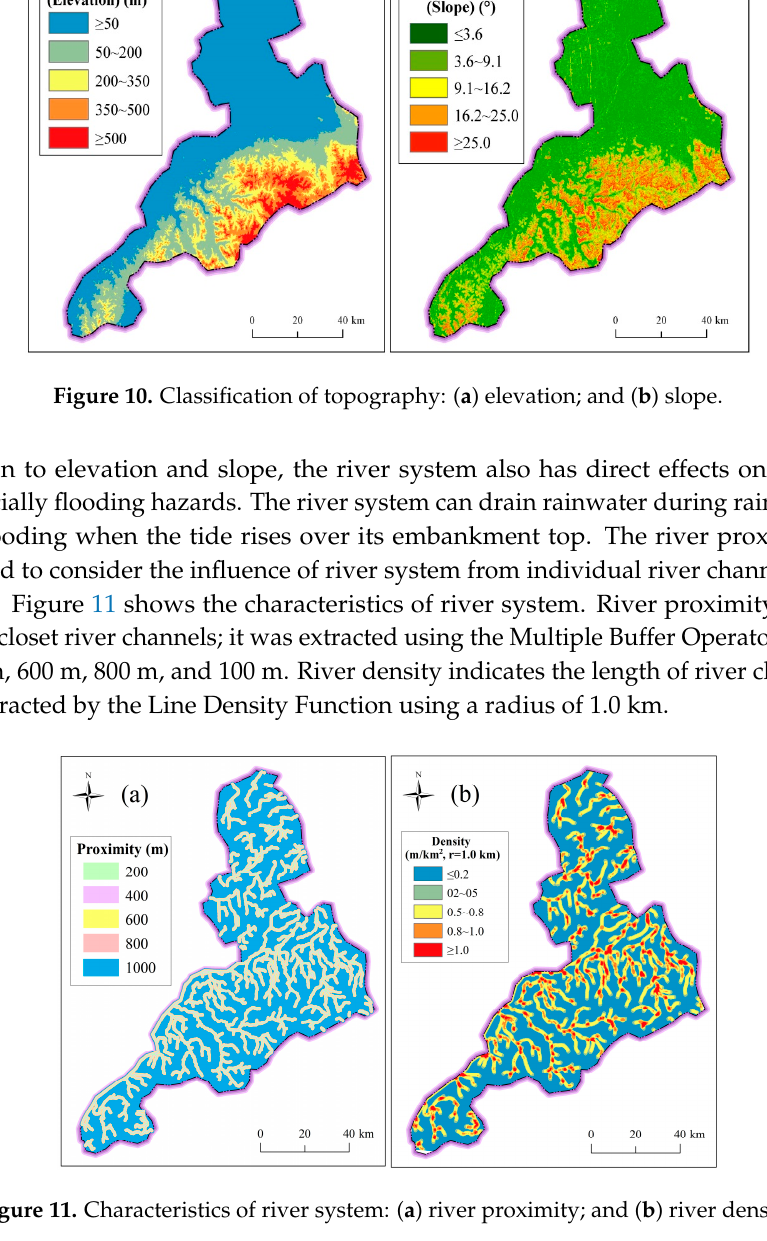
Figure 9. Structure of assessment index system.